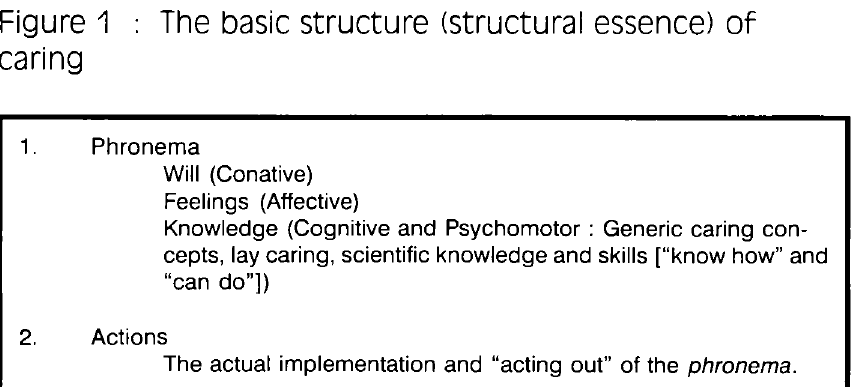
Figure 1 : The basic structure (structural essence) of caring 1. Phronema